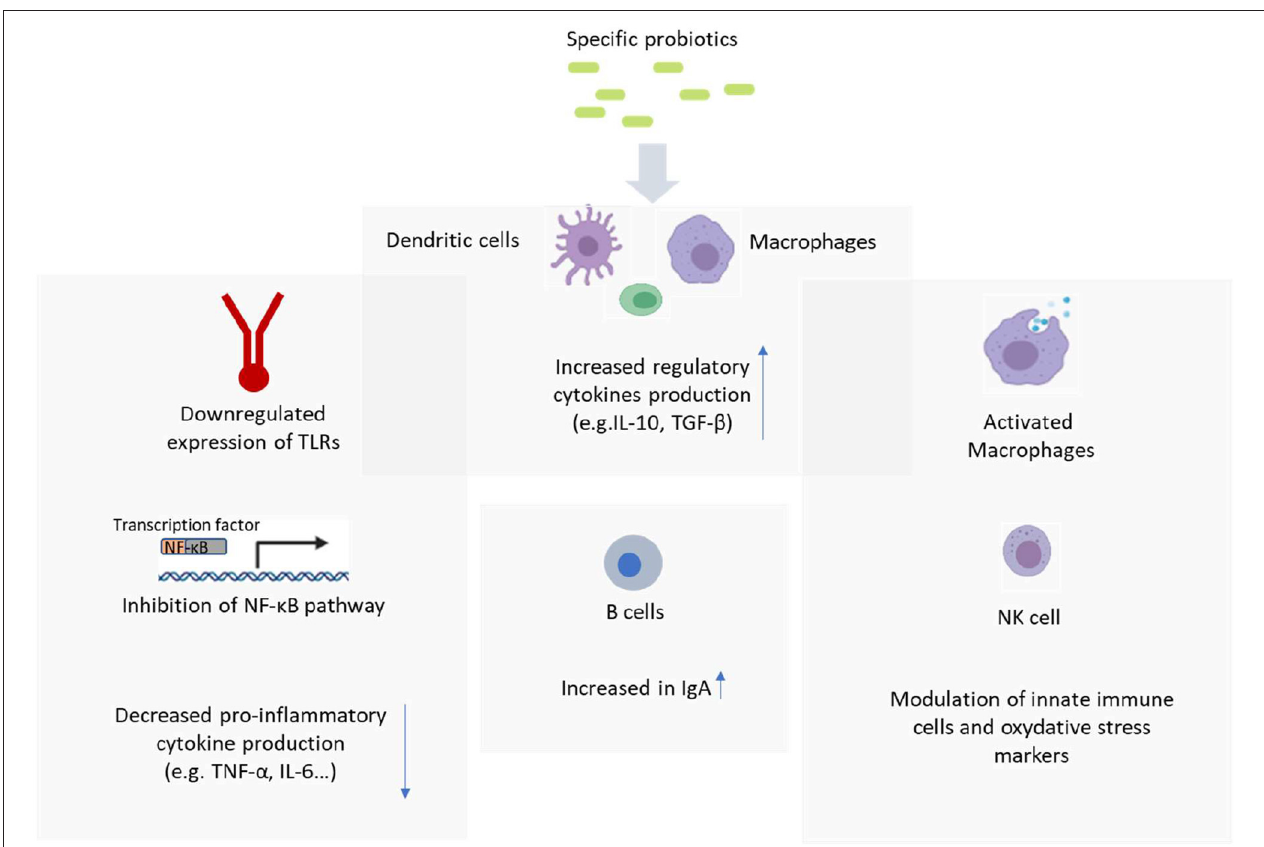
FIGURE 1 | Probiotic mechanism of action. Figure created with